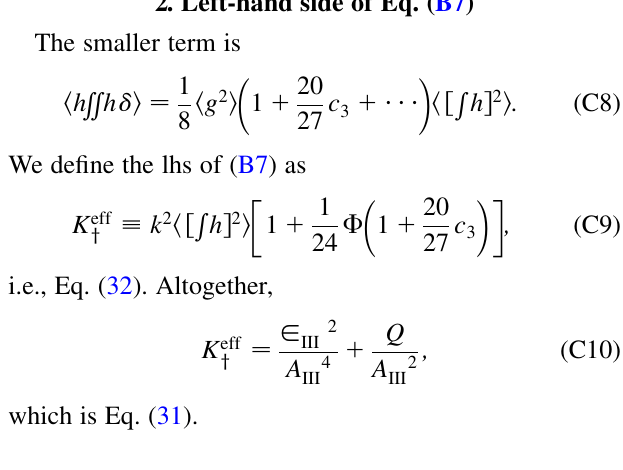
TABLE IV. h different occupancies.